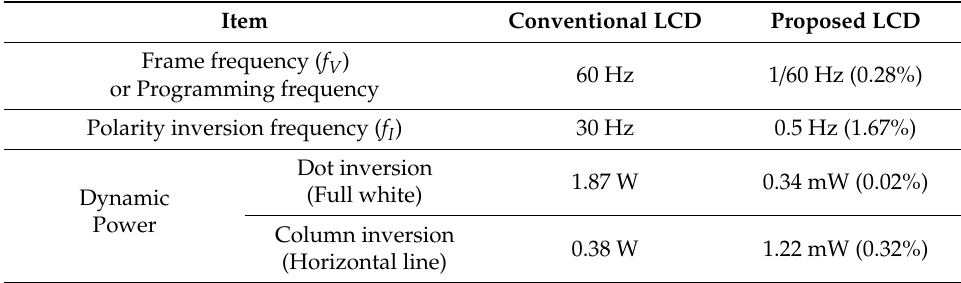
Table 1. Calculated results of dynamic power